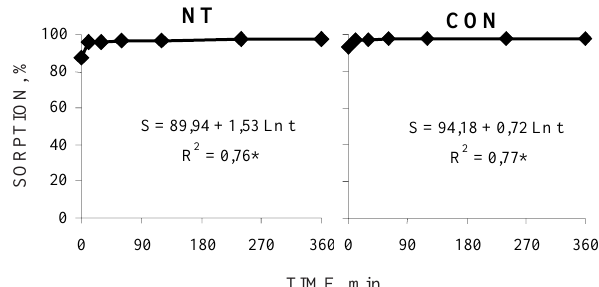
Figure 3. Sorption kinetics of glyphosate and application of the Elovich model to a Brazilian Rhodic Oxisol under 23 years with no-till (NT) or conventional management soil system (CON).